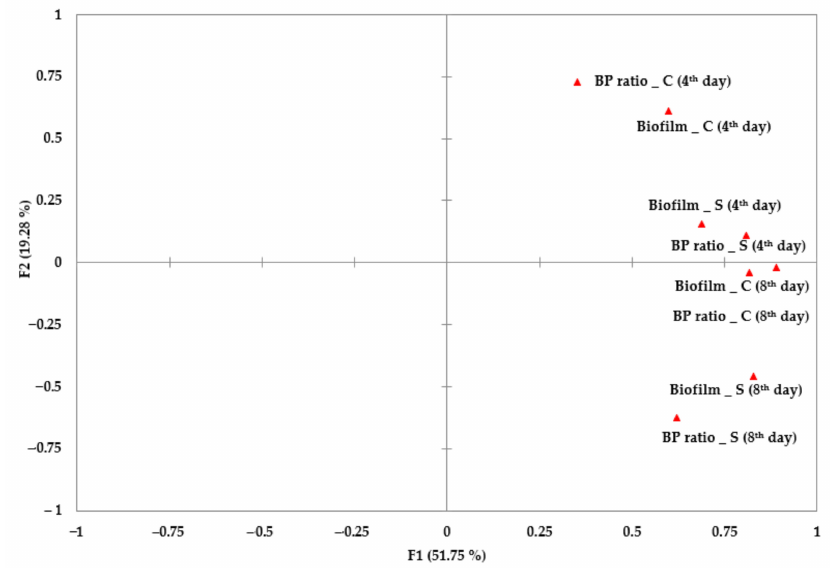
Figure 5. Principal component analysis plots relating biofilm-forming ability and EPS-producing sodic-tolerant bacterial isolates. Biofilm_C—biofilm production under control condition, Biofilm_S— biofilm production under sodic stress conditions, BP ratio_C—the ratio between biofilm production and planktonic population under control conditions, BP ratio_S—the ratio between biofilm production and planktonic population under stress